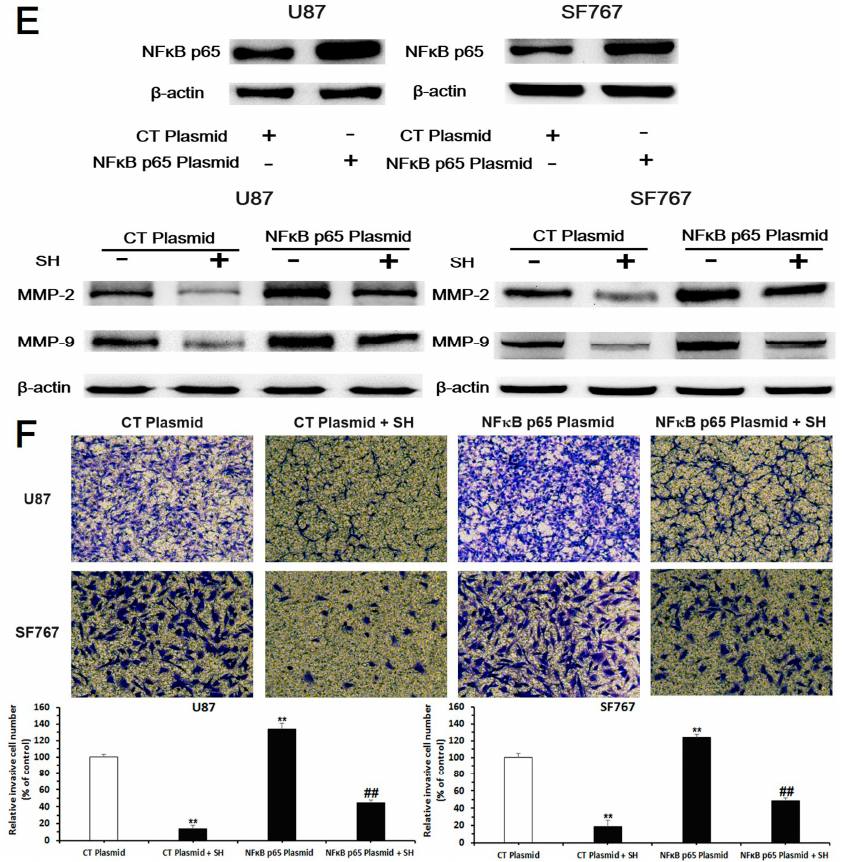
Figure 3. SH reduced matrix metalloproteinase (MMP)-2/-9 expression by suppressing nuclear factor kappa B (NF κ B) activation. ( A ) After treatment with the indicated concentrations of SH for 24 h, levels of the MMP-2/-9 mRNAs in U87 and SF767 cells were assessed by quantitative real-time PCR, and levels of the MMP-2/-9 proteins in the two cell lines were examined using Western blot analysis; ( B ) Co-immunoprecipitation (Co-IP) analysis of the binding of NF κ B p65 and inhibitor of NF κ B (I κ B)- α . Cells were incubated with SH (0.25 mM) for 6 h. An I κ B- α antibody was used in the IP experiment, an NF κ B p65 antibody was used in the subsequent Western blot analysis, and an IgG antibody was applied as the negative control. WCL: whole cell lysates; ( C ) The SH treatment decreased levels of phosphorylated inhibitor kappa B kinase (IKK) β and I κ B- α . U87 and SF767 cells were incubated with the indicated concentrations of SH for 24 h; ( D ) SH inhibited NF κ B p65 expression in U87 and SF767 cells. Prior to the Western blot analysis, cells were treated with the indicated concentrations of SH for 24 h. For the immunofluorescence assays, cells were treated with SH (0.25 mM) for 24 h, fixed, stained with primary antibodies against NF κ B p65, and stained with fluorescein isothiocyanate (FITC)-labeled secondary antibodies (red fluorescence). Nuclei were stained with diamidino-phenyl-indole (DAPI) (blue fluorescence). The protein was observed using a laser scanning confocal microscope, the images of U87 cells were captured at 1000 × magnification and the images of SF767 cells were captured at 400 × magnification; ( E ) Efficiency of NF κ B p65 overexpression and the effects of an NF κ B p65 plasmid on SH-induced down-regulation of MMP-2/-9 expression. Cells were transfected with the no-target control plasmid (CT plasmid) or the NF κ B p65 plasmid for 24 h and then treated with or without SH (0.25 mM) for another 24 h; ( F ) Effects of the NF κ B p65 plasmid on the SH-mediated reduced invasion of the two cell lines in matrigel-coated Transwell invasion assays (100 × magnification). Cells were transfected with the CT plasmid or the NF κ B p65 plasmid for 24 h and then treated with or without SH (0.25 mM) for an additional 24 h. Each image is representative of n = 3 experiments. All blots shown above are representative of n = 3 experiments with similar results. β -Actin served as the loading control. All data are presented as means ± SEM, n = 3. ** p < 0.01 compared with the control; ## p < 0.01 compared with the NF κ B p65 plasmid-transfected group.